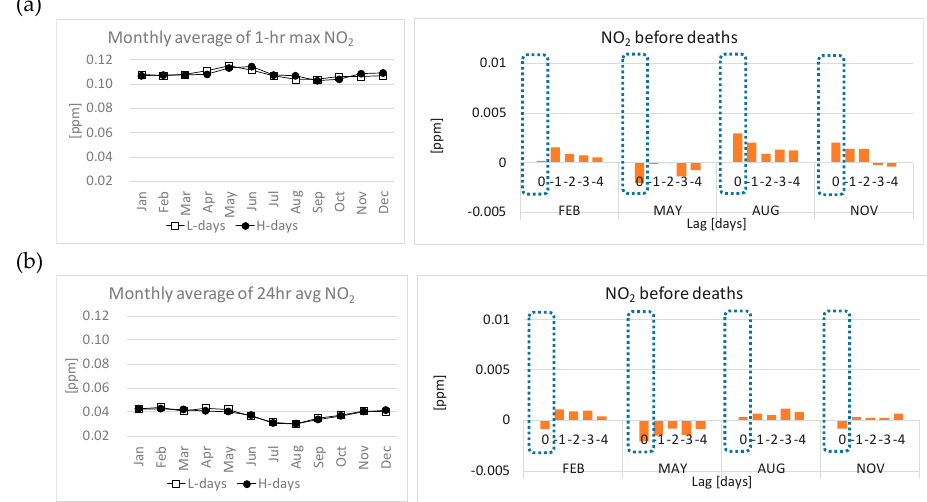
Figure 6. Nitrogen dioxide (NO 2 ) concentrations on days with a higher or lower probability of death from respiratory disease and those from zero to 5 days before deaths in February, May, August, and November between 2008 and 2017: ( a ) 1-hour maximum and ( b ) 24-hour average NO 2 concentrations. The average temperature on days from February to April with high numbers of deaths was lower than on days with a low number of deaths (Figure 7). This result is consistent with a previous study showing that high numbers of deaths by respiratory disease occurred on days with low temperatures in winter [36,37]. However, average temperatures on the days with high numbers of deaths were slightly higher in most cases than on the days with low numbers of deaths. This was partly because of the relatively low particle concentrations observed on cold days.